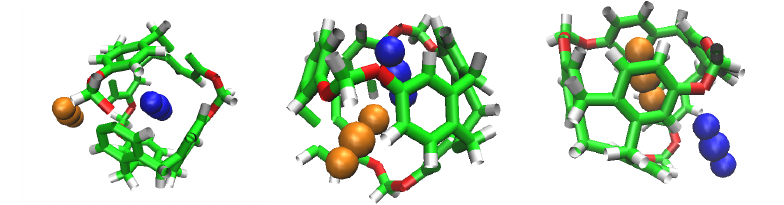
Figure 6. CO 2 replacement by another CO 2 . Beginning, Half and Final